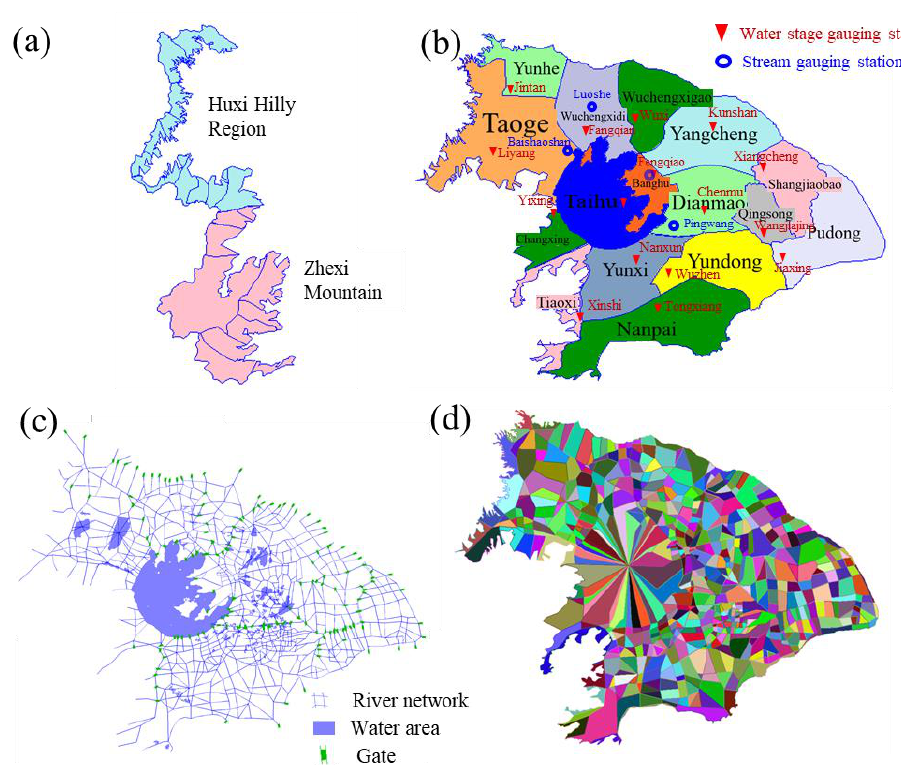
Figure 4. The distribution map of overland runoff units in ( a ) hilly and ( b ) plain areas including water stage gauging station and stream gauging station; ( c ) the generalization of the river network, lakes, and gates (in green) in Taihu Basin, and ( d ) the river network polygon for Taihu Basin.